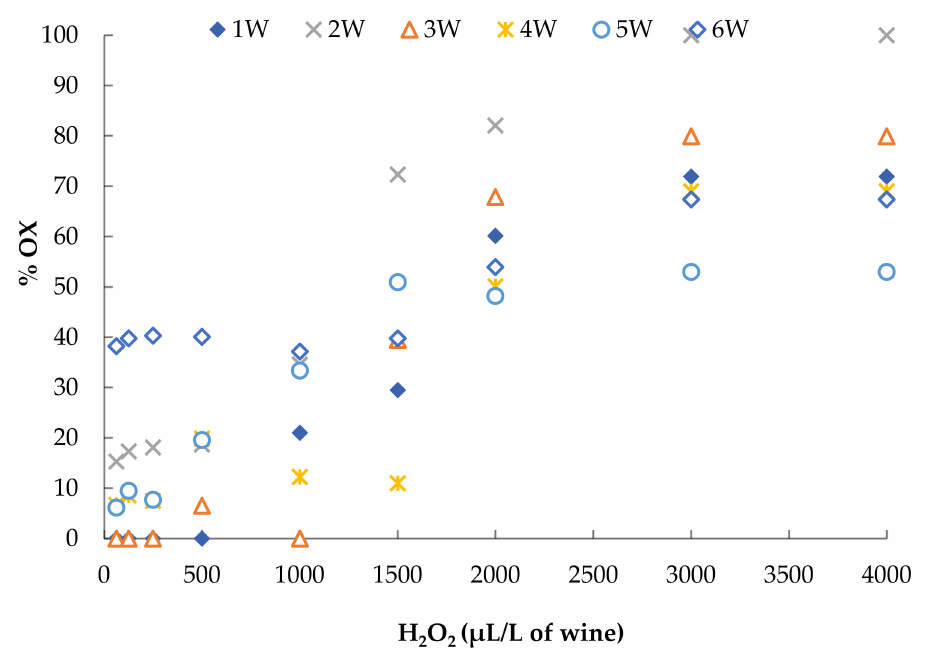
Figure 4. Results of POM test performed with increasing doses of 3% H 2 O 2 , from 62.5 to 4000 µ L/L of white